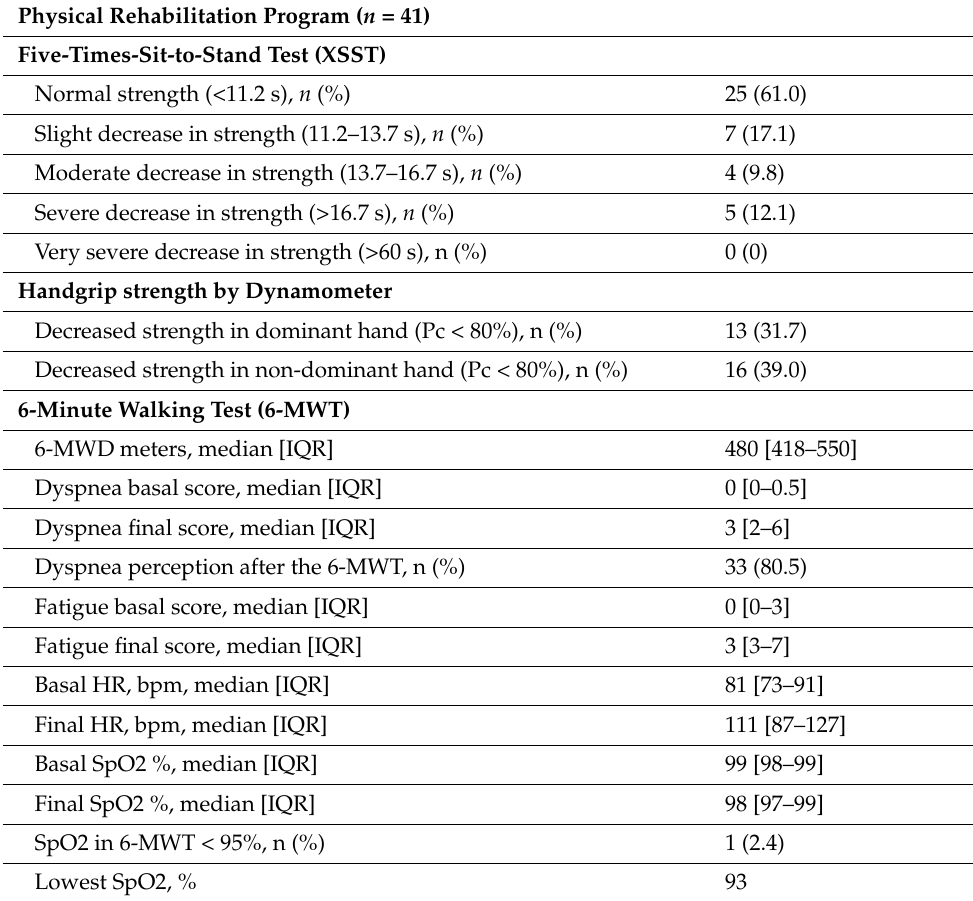
Table 2. Effects of long COVID on the physical activity of pediatric patients ( n =